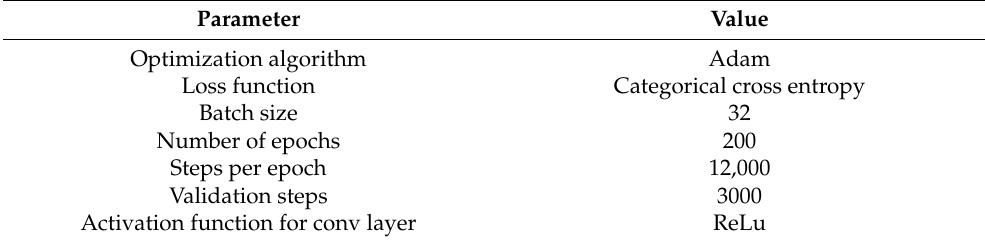
Table 2. Training Parameters for the Proposed